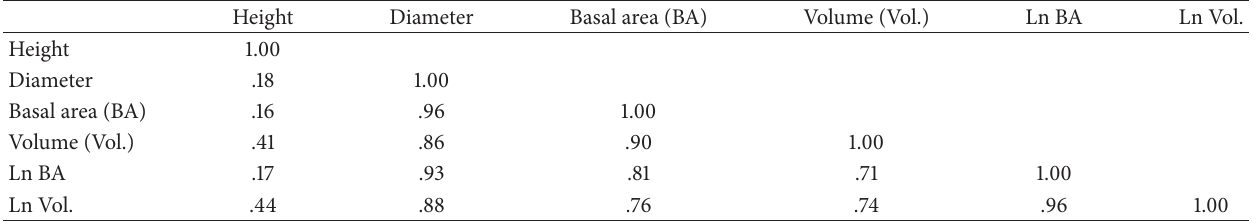
Table 5: Correlation coefficients for tree growth variables in periurban area (Lugbe).